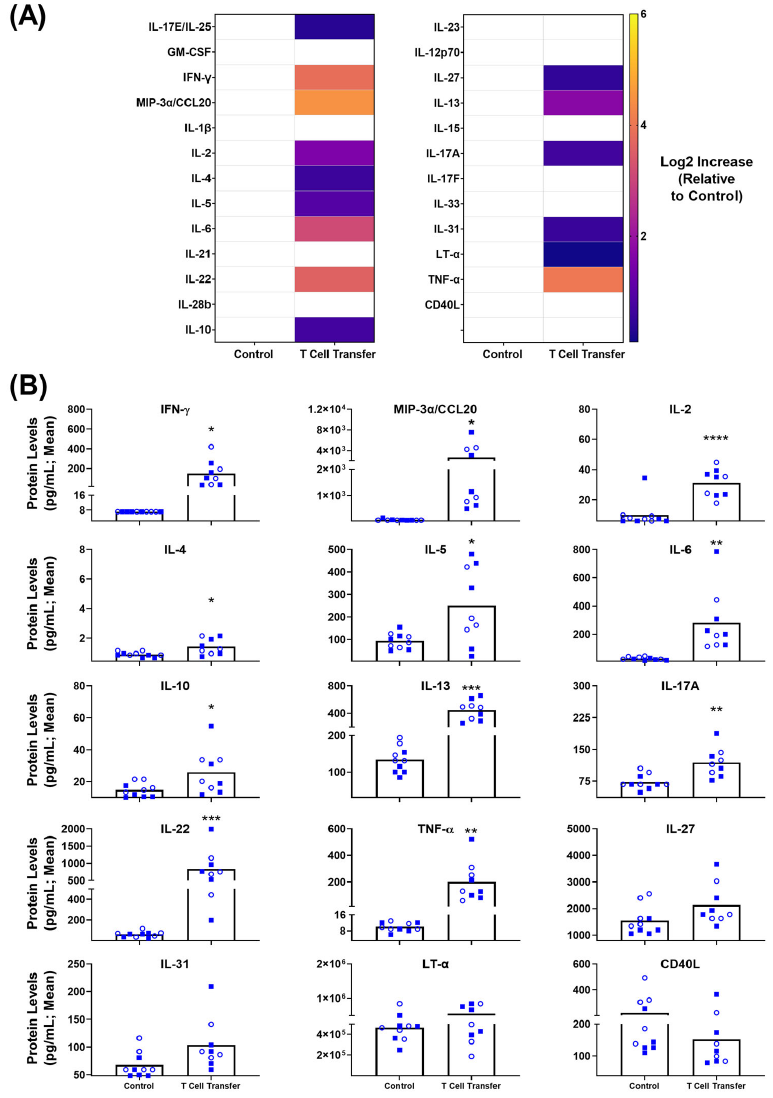
Figure 4. Inflammatory markers dysregulated within chronic, T cell transfer colitis model. Rag KO mice (n = 10/group) were injected i.p. with proinflammatory (CD4+ CD25 LOW CD45RB HIGH isolated from spleens of C57BL/6 mice. At the time of euthanasia (Day 64 or humane endpoint), serum was collected and used for a multiplexed cytokine/chemokine analysis. Raw concentration values were determined through use of a standard curve using the Milliplex™ Analyst software. These values were normalized to the control animals for a baseline, and the mean Log2 Increase ( A ) was plotted. Grouped data of raw concentrations ( B ) are presented as mean + standard error of mean (SEM). Circles (empty) and squares (filled) represent Rag1 ‐ / ‐ and Rag2 ‐ / ‐ mice, respectively. Statistical significance of differences are compared relative to the control group and are shown as *: p < 0.05, **: p < 0.01, ***: p < 0.001 & ****: p < 0.0001 by two ‐ tailed unpaired parametric t ‐ tests with the Welch’s correction.